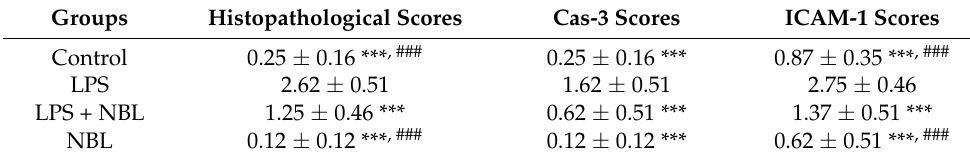
Figure 1. Histopathological appearance of the lungs in study groups: ( A ) normal microscopical ap- pearance in lungs in a rat belonging control group; ( B ) marked increase in septal tissue thickness (arrows) in lungs in a rat from LPS group; ( C ) marked amelioration and decreased septal tissue thickness (arrow) in a rat in LPS + NBL group; and ( D ) normal lung tissue architecture in a rat belonging NBL group, H&E, scale bars = 50 µm. Table 3. Results of statistical analysis of immunohistochemical scores between the groups. Groups Histopathological Scores Cas-3 Scores ICAM-1 Scores Control Figure 2. Cas-3 immunohistochemical findings among the groups: ( A ) negative expression in con- trol group; ( B ) increased Cas-3 expression (arrows) in both alveolar epithelial cells and inflamma- tory cells (arrows) in LPS group; ( C ) decreased expression (arrow) in LPS + NBL group; and ( D ) no expression in NBL group, Streptavidin biotin method, scale bars = 20 µm.